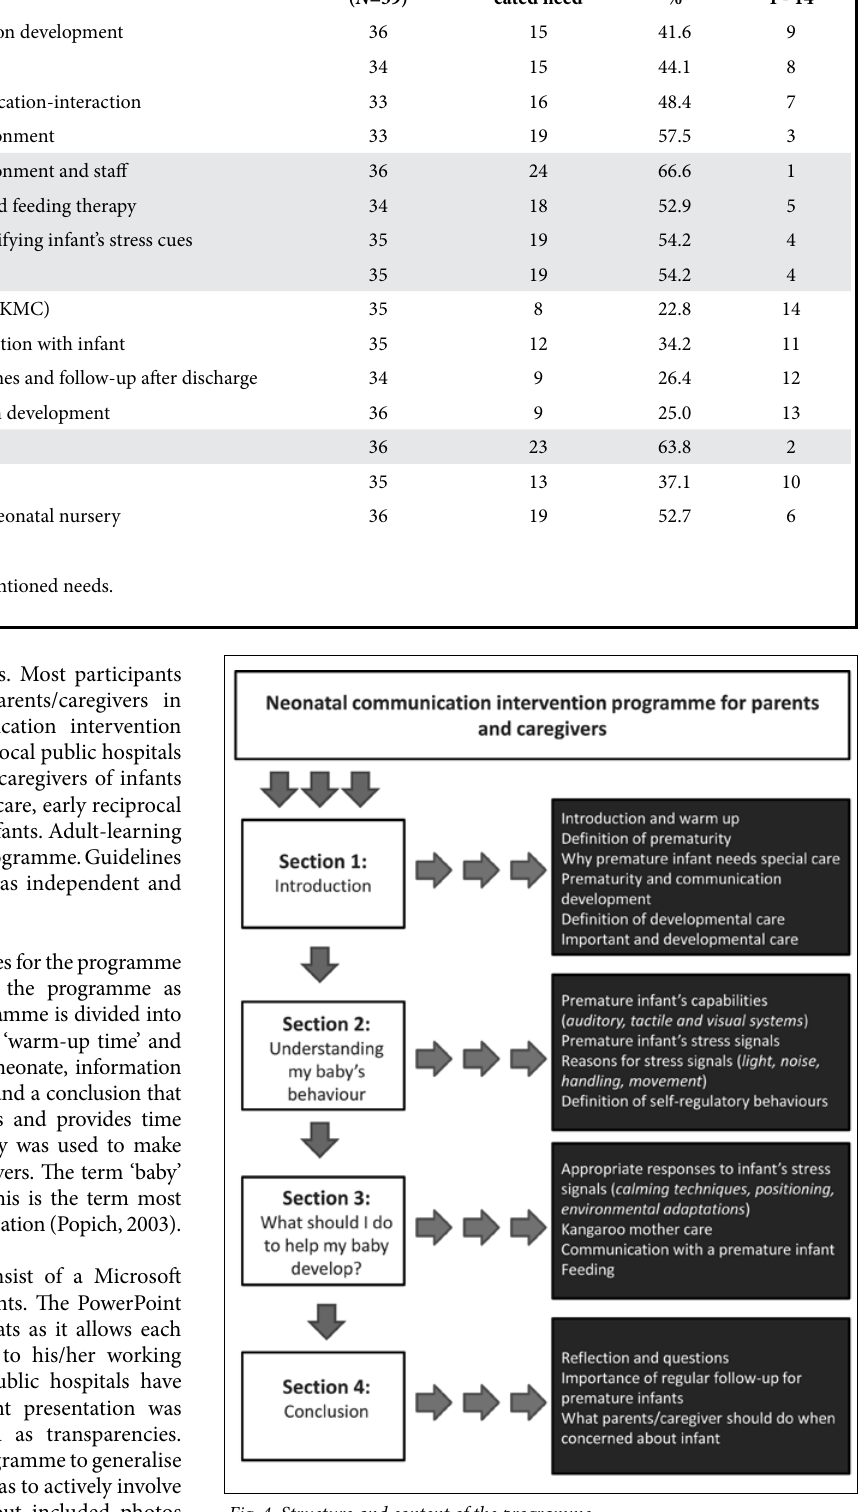
Fig. 4. Structure and content of the